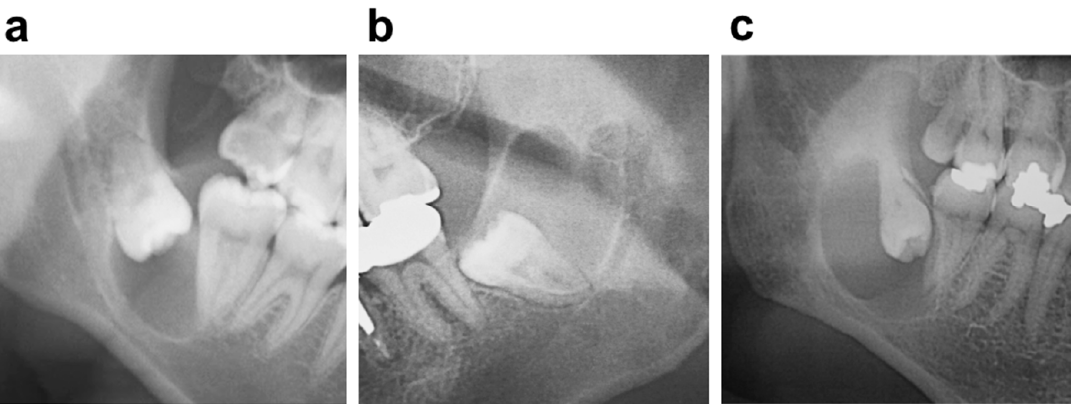
Figure 1. A dentigerous cyst ( a ) unilocular and crown side type; ( b ) multilocular type; ( c )